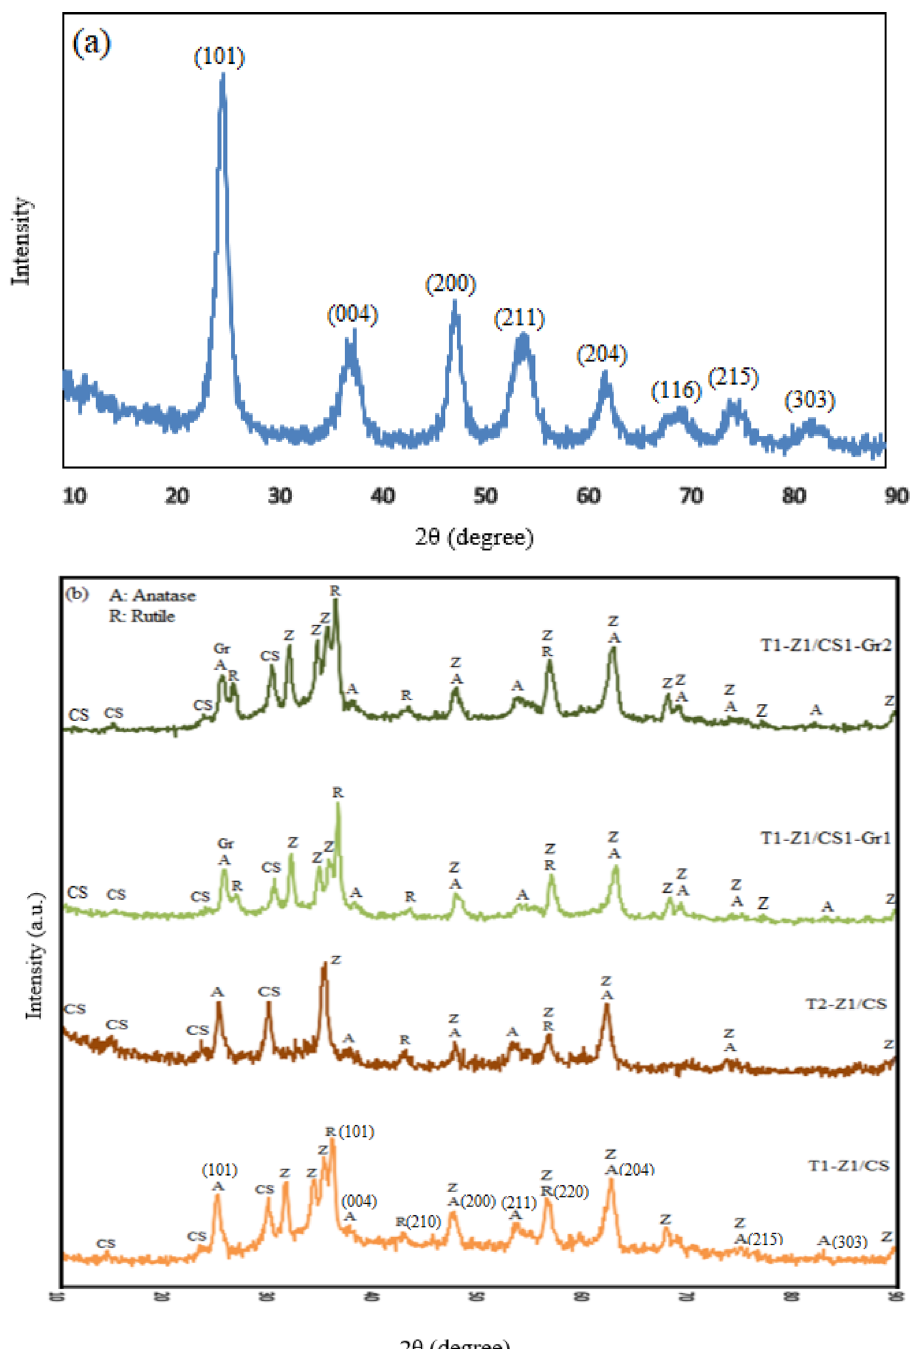
Figure 1. XRD patterns of ( a ) pure TiO 2 ( b ) composite